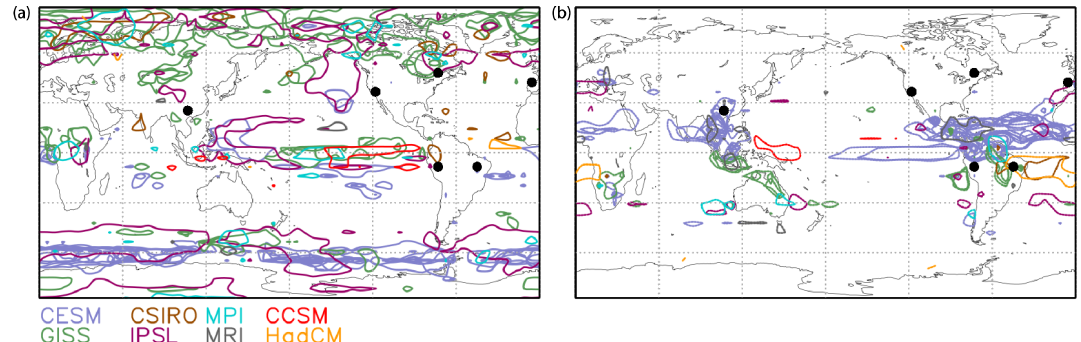
Figure 13. Regions showing high positive (a) or negative (b) correlation between precipitation and the mode of precipitation associated with the forcing for the ensemble of simulations included in Table 1. Contours of correlation equal to − 0 . 6 and 0.6 are shown for each simulation. Dots indicate locations where the time series of Fig. 14 have been